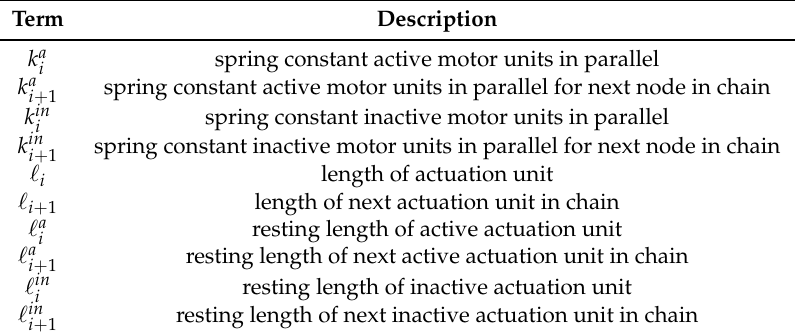
Table 1. Nomenclature for Equation